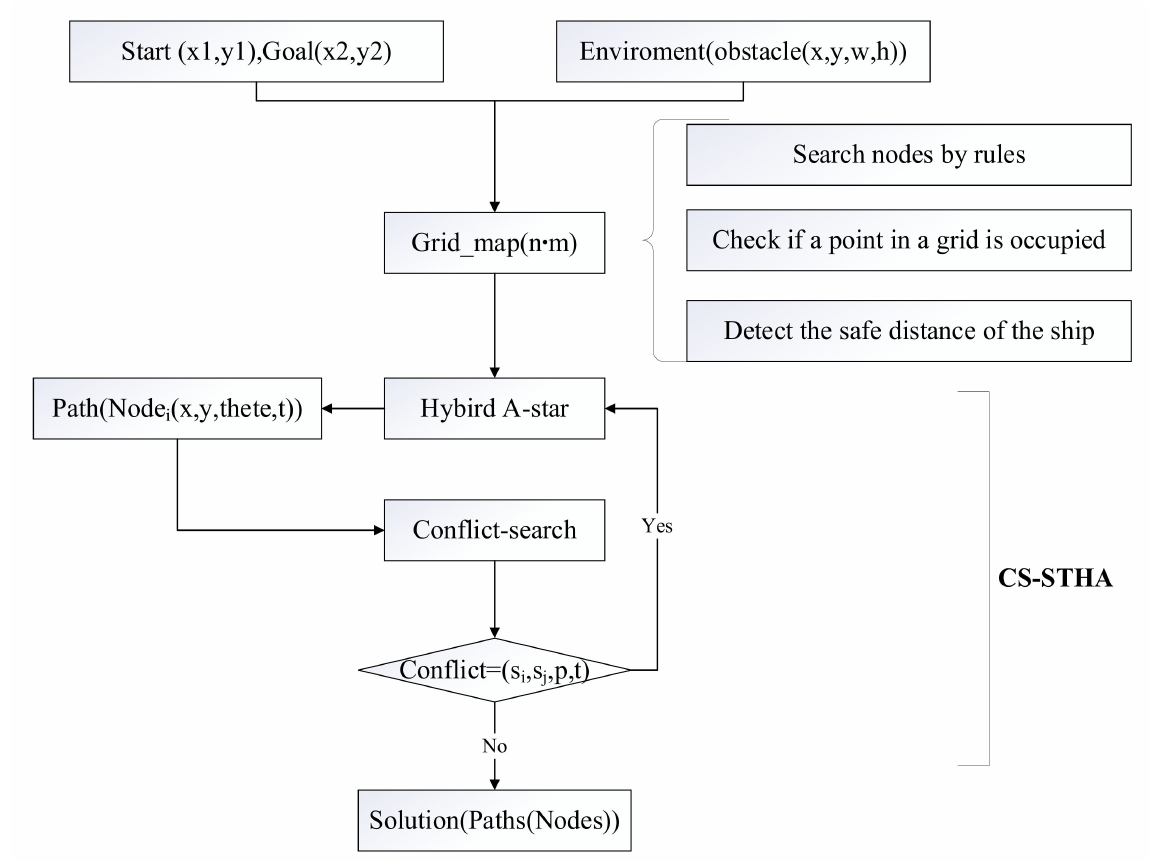
Figure 1. Algorithmic flowchart of multi-ship collaborative collision avoidance